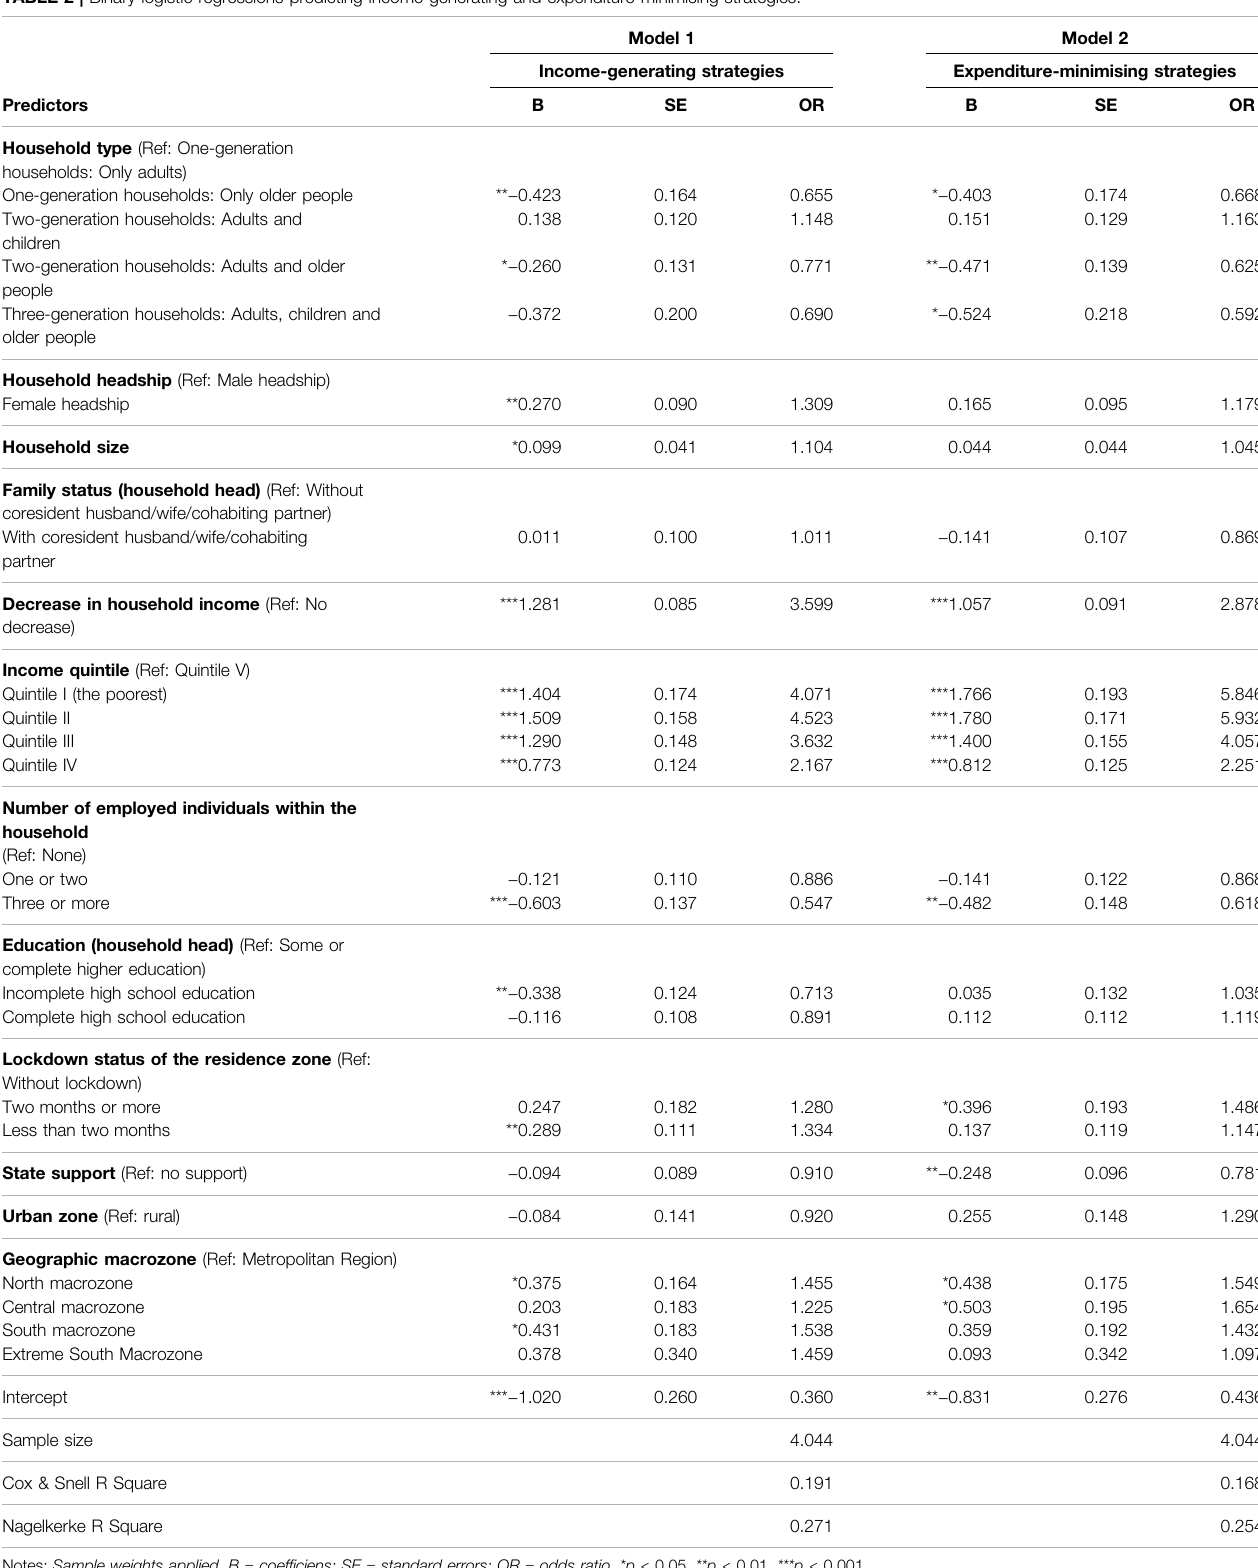
TABLE 2 | Binary logistic regressions predicting income-generating and expenditure-minimising